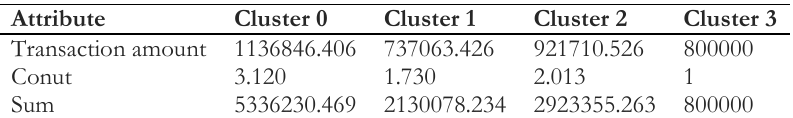
Table 1. Average amounts and frequency of card use in four clusters.